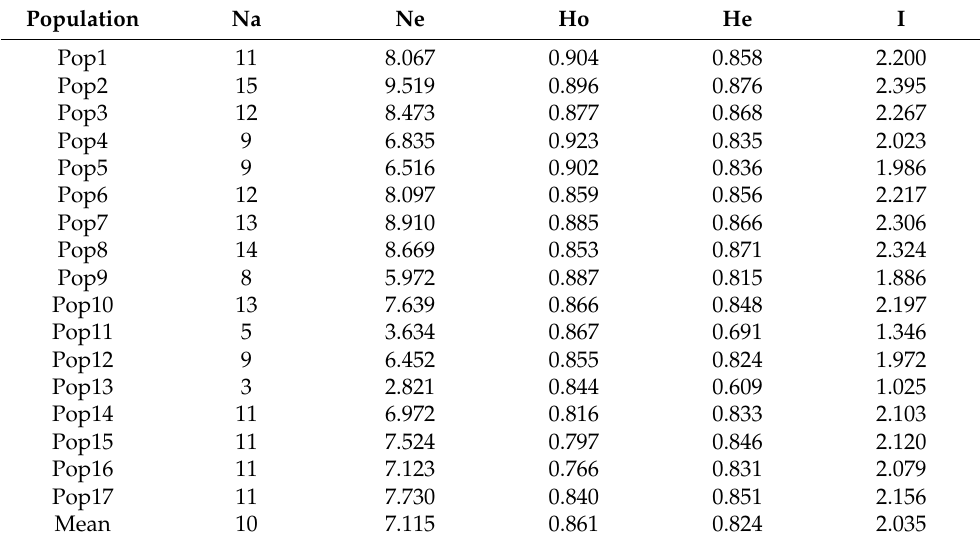
Table 3. Genetic diversity parameters of the 17